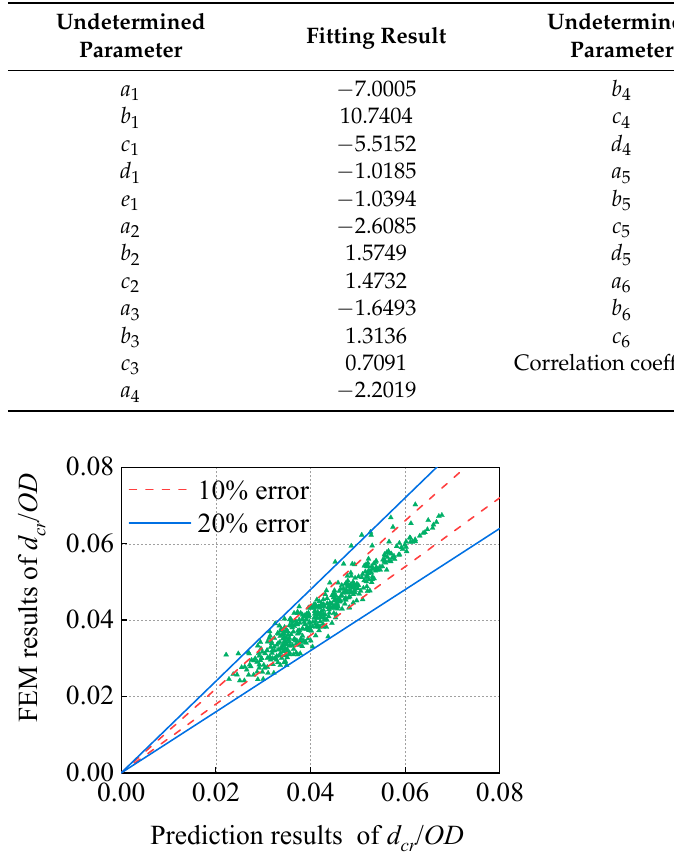
Figure 21. Comparison between the prediction formula and FEM.